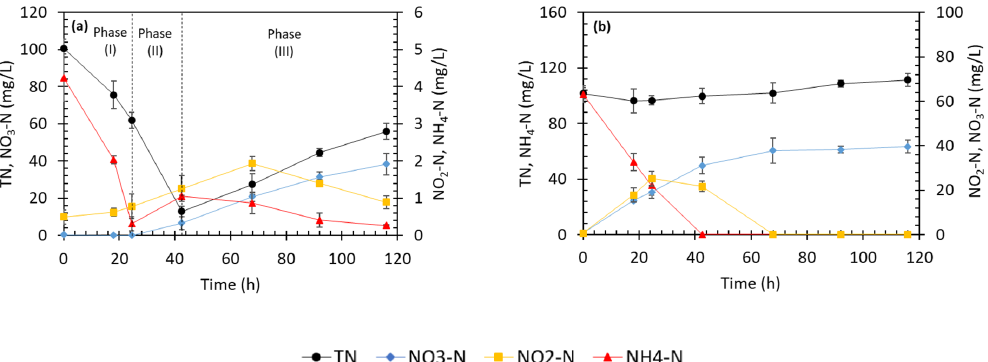
Figure 1. Treatment performance of ( a ) heterotrophic nitrification (HN_AS) and ( b ) autotrophic nitrification activated sludge (AN_AS) bioreactors.